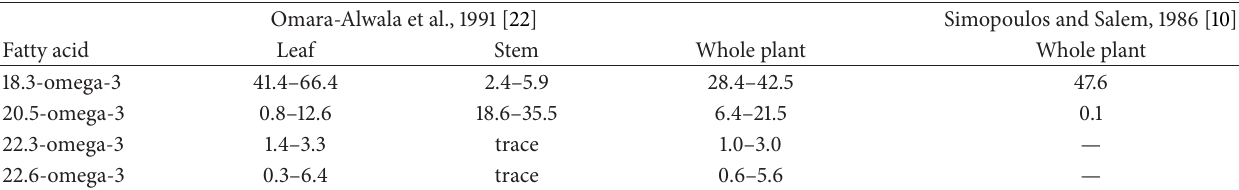
Table 3: Composition of selected fatty acids in purslane ( Portulaca oleracea ) (% of total FA) a .